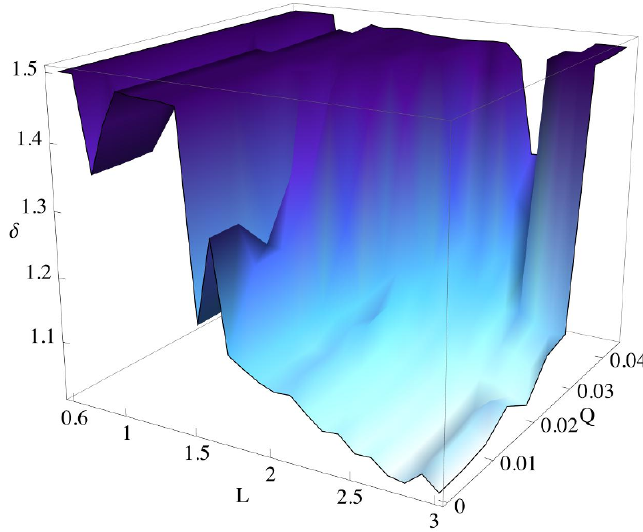
Figure 5 . This (cid:12)gure illustrates the sharp transition between (cid:14) = 1 and (cid:14) = 1 : 5 in the logarithmic decay of the HEE as a function of Q and L for M = 0 : 01 and (cid:27) = 2. surface. Taking (cid:27) = 2 reveals an even richer picture in which we observe a sharp transition between decays characterized by (cid:14) = 1 and (cid:14) = 1 : 5. As illustrated in (cid:12)gure 5, the late-time evolution of holographic entanglement entropy in the neutral, large size limit is (cid:12)tted best with (cid:14) = 1. The exponent (cid:14) = 1 : 5 appears either as extremality is approached, as in the (cid:27) = 0 : 5 case, or in the small L limit, as in the M = 0 : 1